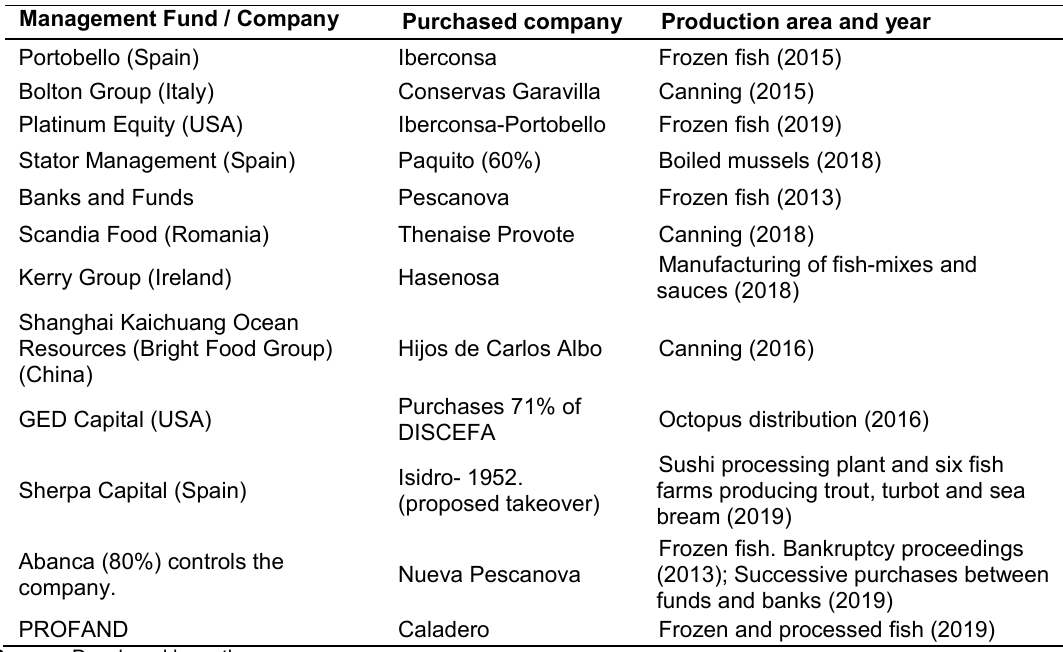
Table 2. Presence of foreign companies, investment funds and financial entities in Galician fishing